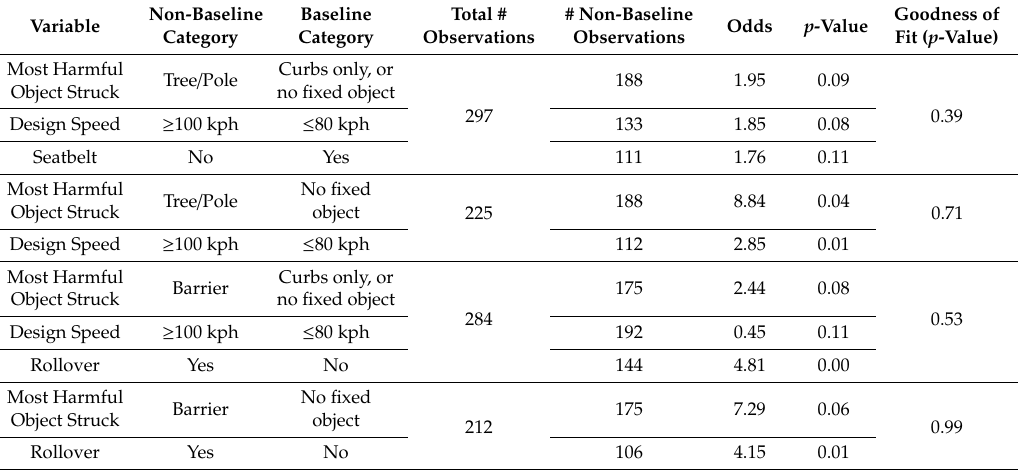
Table 6. Multivariate Analysis